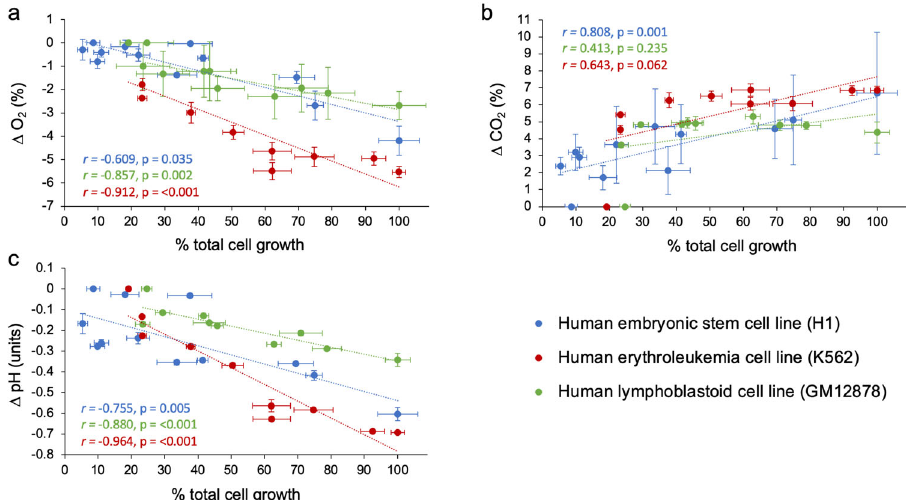
Fig. 4 A comparison of relationships between changes in environmental parameters and cell growth in cultures of H1 hESC, K562, and GM12878. Delta ( Δ ) values for ( a ) dO 2 , ( b ) dCO 2 , and ( c ) pH represent the mean difference between levels measured at 8 h intervals minus measurements taken at time zero. Percent cell growth was calculated based on the assumption that cell densities at 72 h represent 100% cell growth and used to facilitate comparison among the cell line cultures despite differences in cell density units. Data points represent mean values across the three replicate fl asks ±1 standard error for each cell line. Insets show the Pearson correlation coef fi cient ( r ) and p -value for each correlation model (cf. Supplementary Table S1 for full statistical